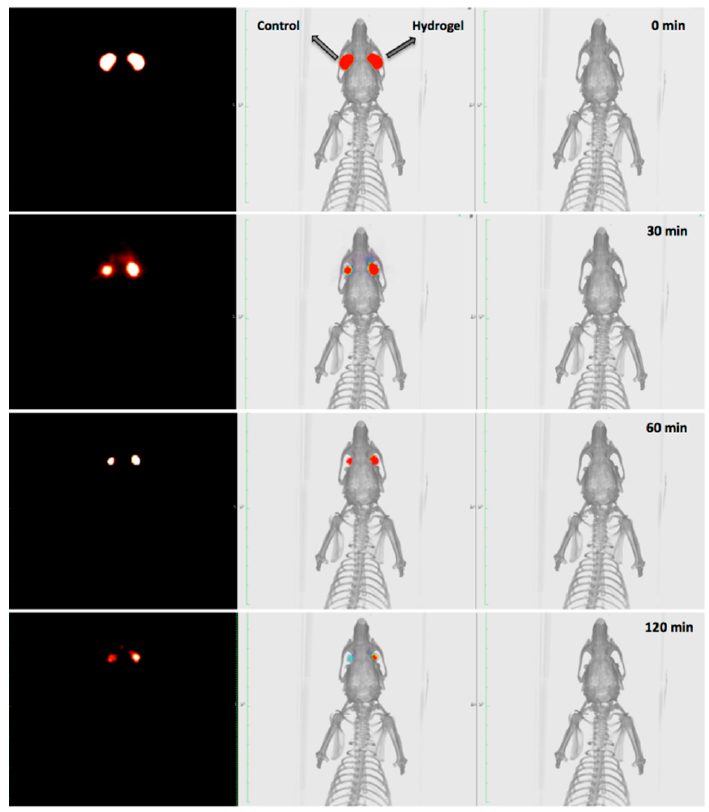
Figure 2. PET (left), CT (right), and PET / CT fused image. The biopermanence evaluation of the hydrogel labeled with 18F-fluorodeoxyglucose (FDG) (right eye) in rats compared to a saline solution containing 18F-FDG as control formulation (left eye). Reproduced from [33], which is licensed under